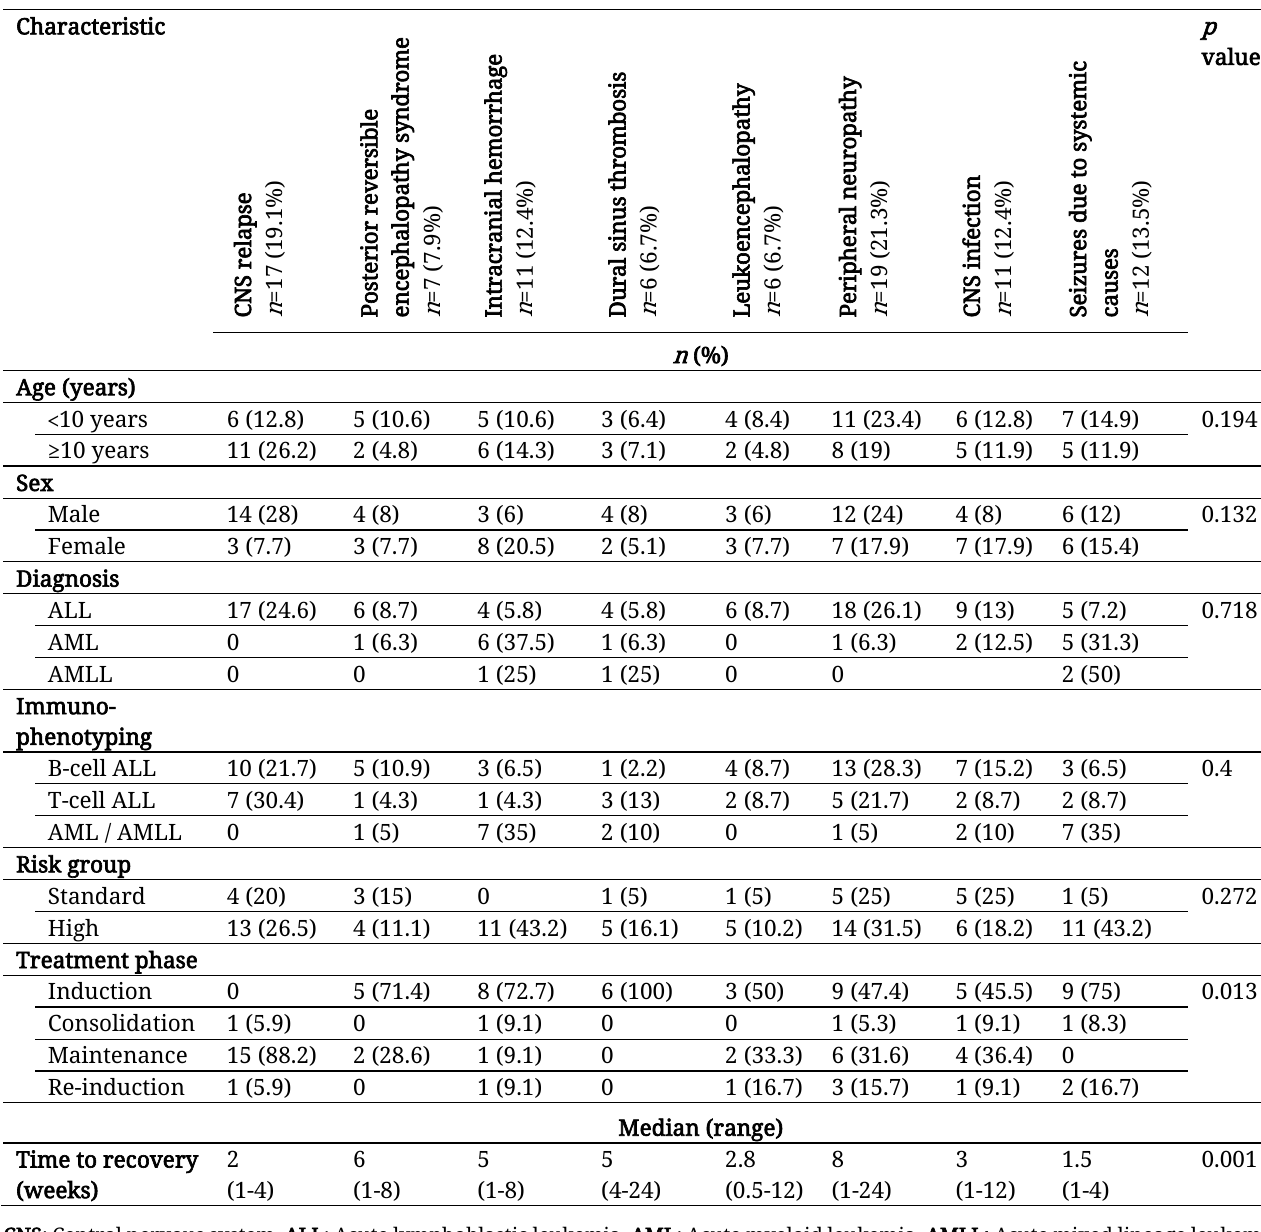
Table 2: The relationship between neurological complications and characteristics of 89 children with acute